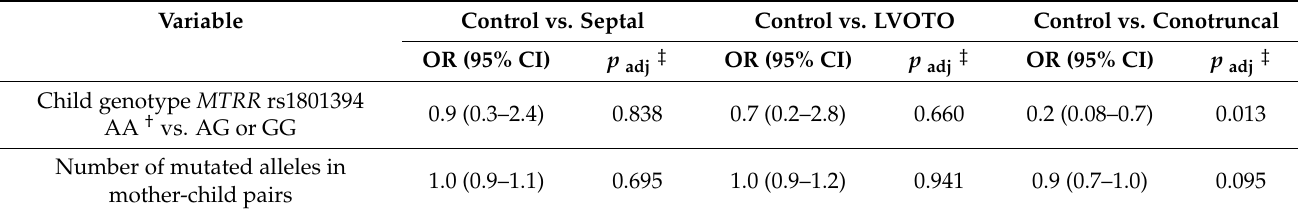
† Reference category. ‡ All genetic risk factors were adjusted for environmental risk factors listed in Table 2. Odds ratio (OR), 95% confidence interval, and adjusted p values were calculated in multinomial logistic regression models for mothers and children separately. Only variables with unadjusted p values < 0.250 were included in the multinomial logistic regression models and adjusted for co-variables.